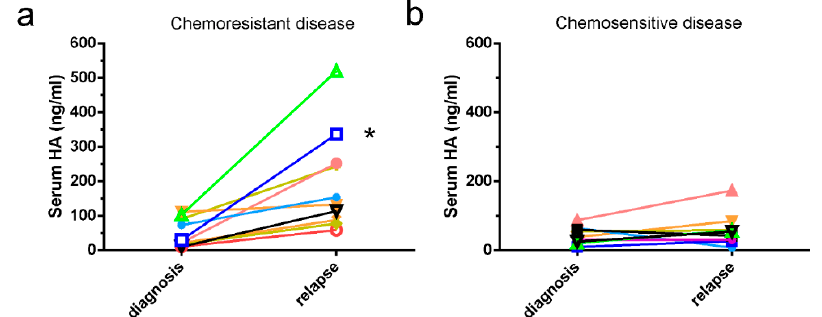
Figure 1. Serum hyaluronan (HA) is elevated in patients with chemoresistant disease. ( a ) HA serum levels (ng/mL) in serous ovarian cancer patients at initial diagnosis and following relapse with chemoresistant disease ( n = 9). * significantly different from levels at diagnosis ( p = 0.0039, Wilcoxon pair test). ( b ) HA serum levels (ng/mL) in serous ovarian cancer patients at initial diagnosis and following relapse with chemosensitive disease ( n = 7, p = 0.219, Wilcoxon pair test).